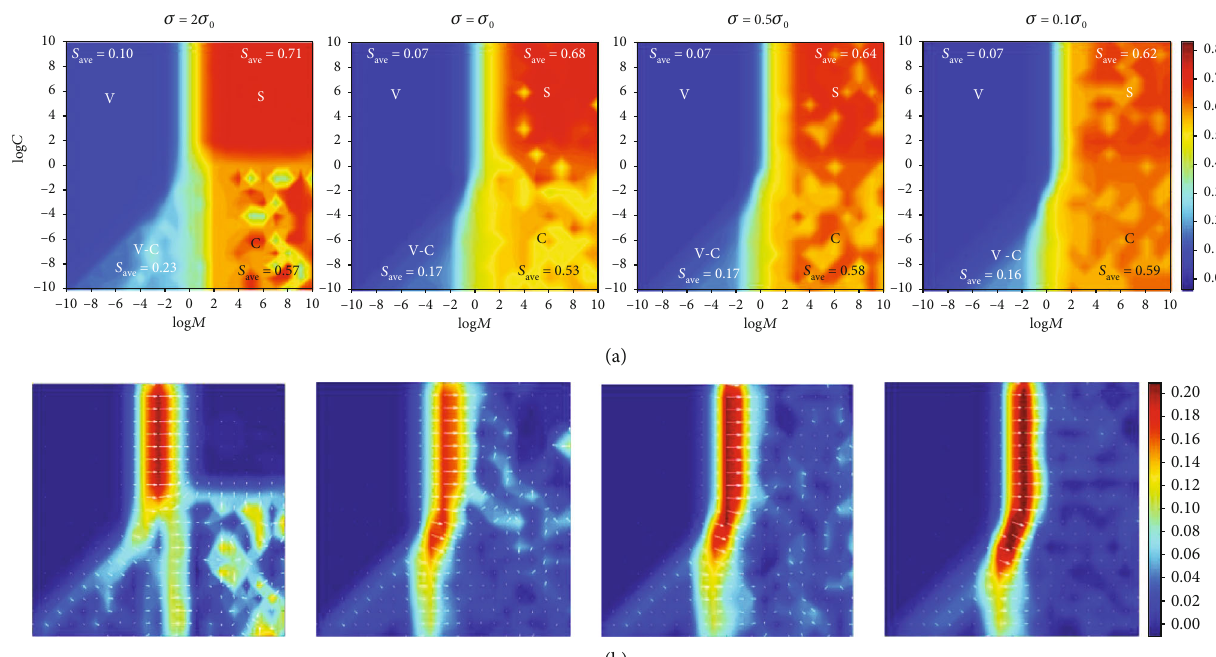
Figure 6: E ff ect of the tube size distribution on the displacement e ffi ciency for the tube network model with a coordination number of cn = 8 : 0 . The tube size distribution changes from σ = 2 σ shown for each zone. (b) Gradient in the displacement e ffi ciency distribution.